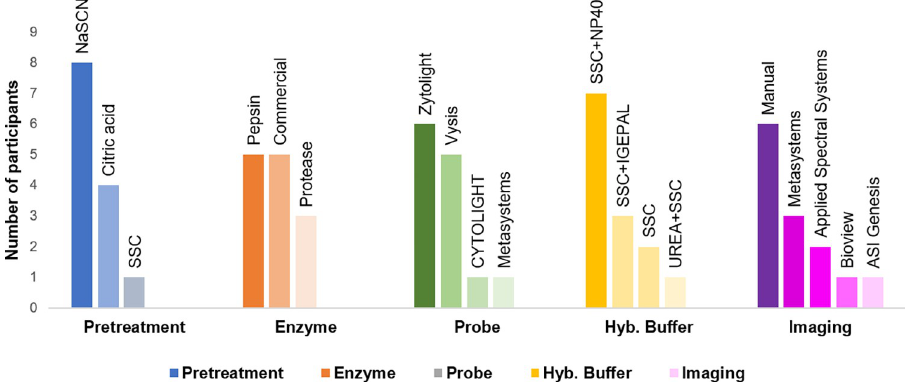
Fig 5. Trend of different methods of pre-treatment, enzymes used, probe used along with hybridization buffer and image analysis software employed by participants for the FISH- HER2/neu module.